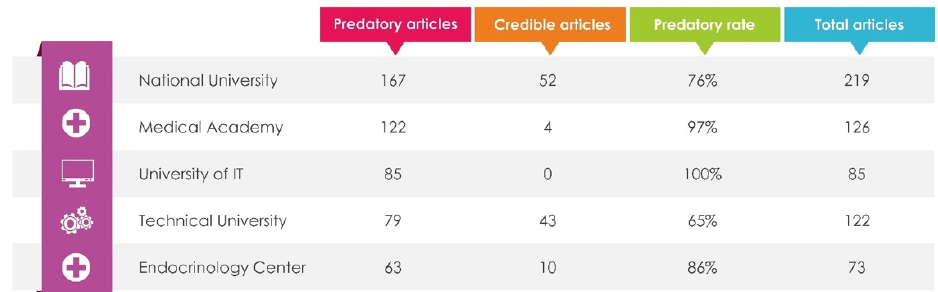
Figure 9. Top-five universities based on the number of predatory articles.